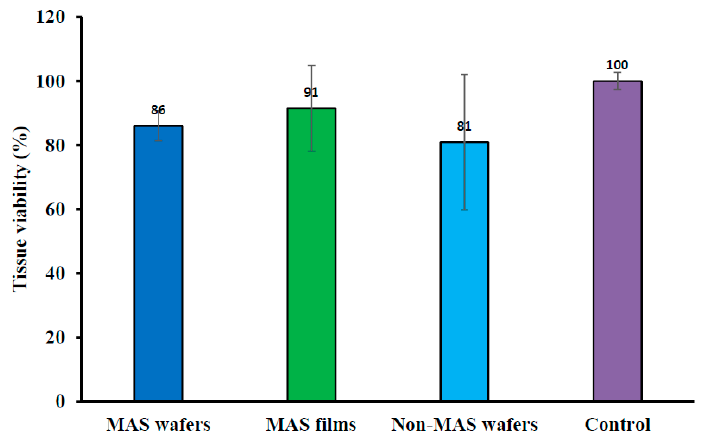
Figure 11. EpiOral TM tissue viability after permeation studies of MAS wafers, MAS films, non-MAS wafers, and negative (non-treated) control ( n = 3, ± SD).